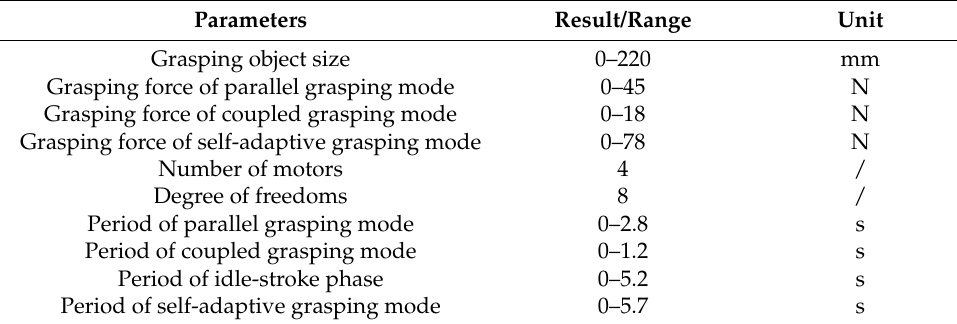
Table 4. Universal grasping experiments parameter measurement results.